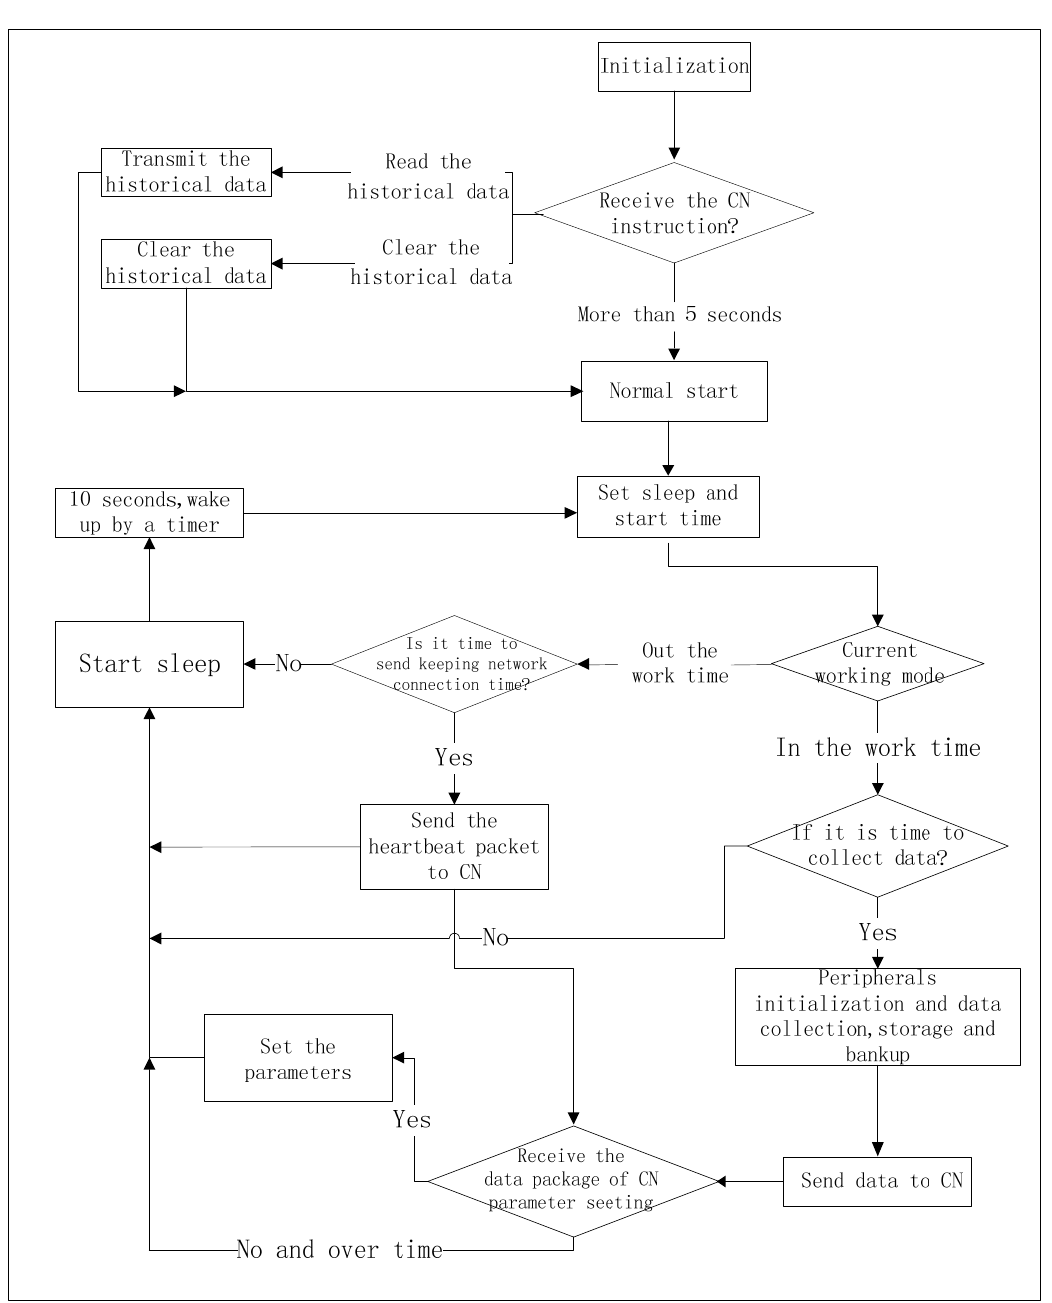
Figure 4. Workflow of MLAOS control